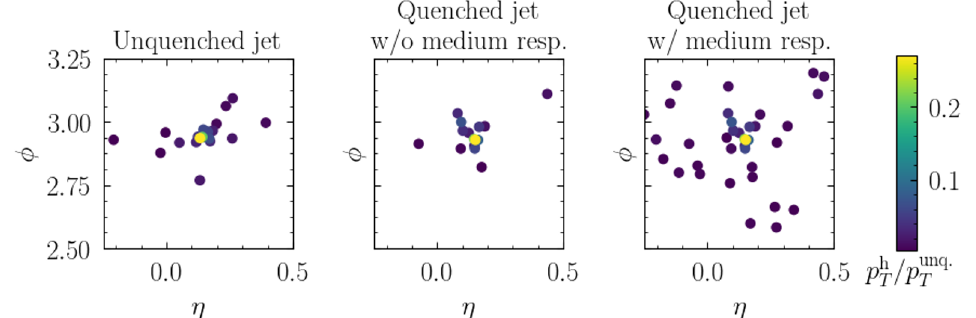
Figure 1. Illustration exemplifying the Monte Carlo matching procedure. Left panel: ( η, φ ) distri- bution of hadrons in an unquenched jet, as reconstructed. Middle panel: the same jet, reconstructed after quenching but upon leaving out hadrons originating from the response of the medium, e.g. the wake the jet excites. Right panel: the same jet, reconstructed after quenching, with hadrons from the medium response included. Color indicates hadron p T as a fraction of the p T of this unquenched jet, which has p unq. = 177 T